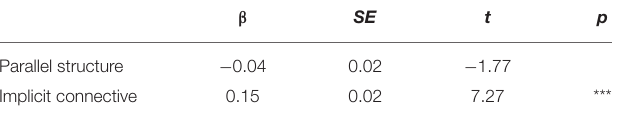
TABLE 3 | Model of the L2 data (Experiment 1).